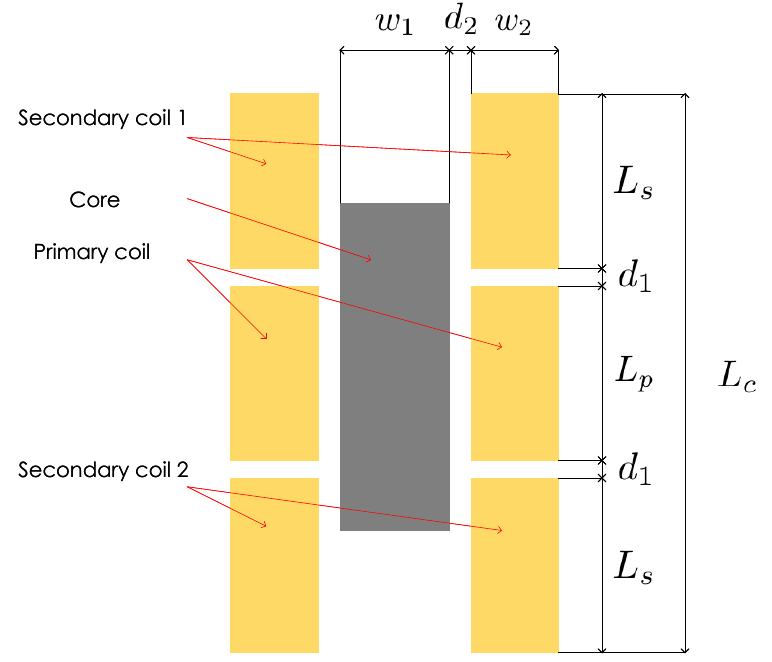
Figure 5. LVDT design for